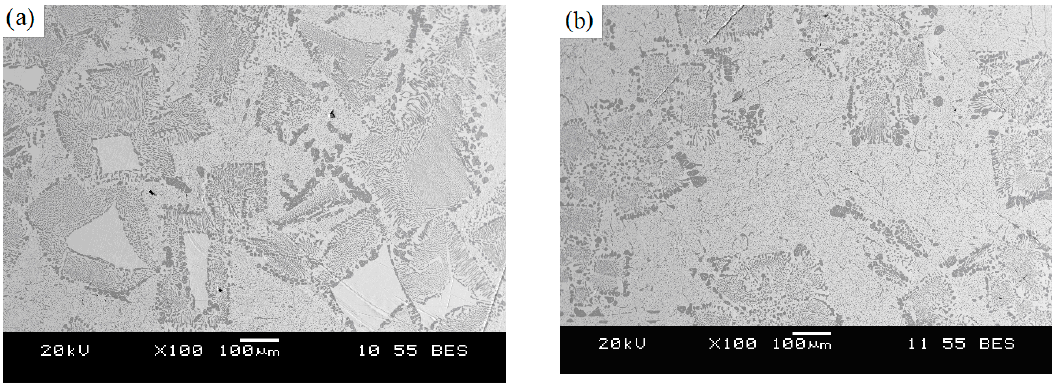
Figure 7. Microstructure of samples of Bi–18Sn–32Pb alloy ( a ) without treatment and ( b ) after EMP processing.